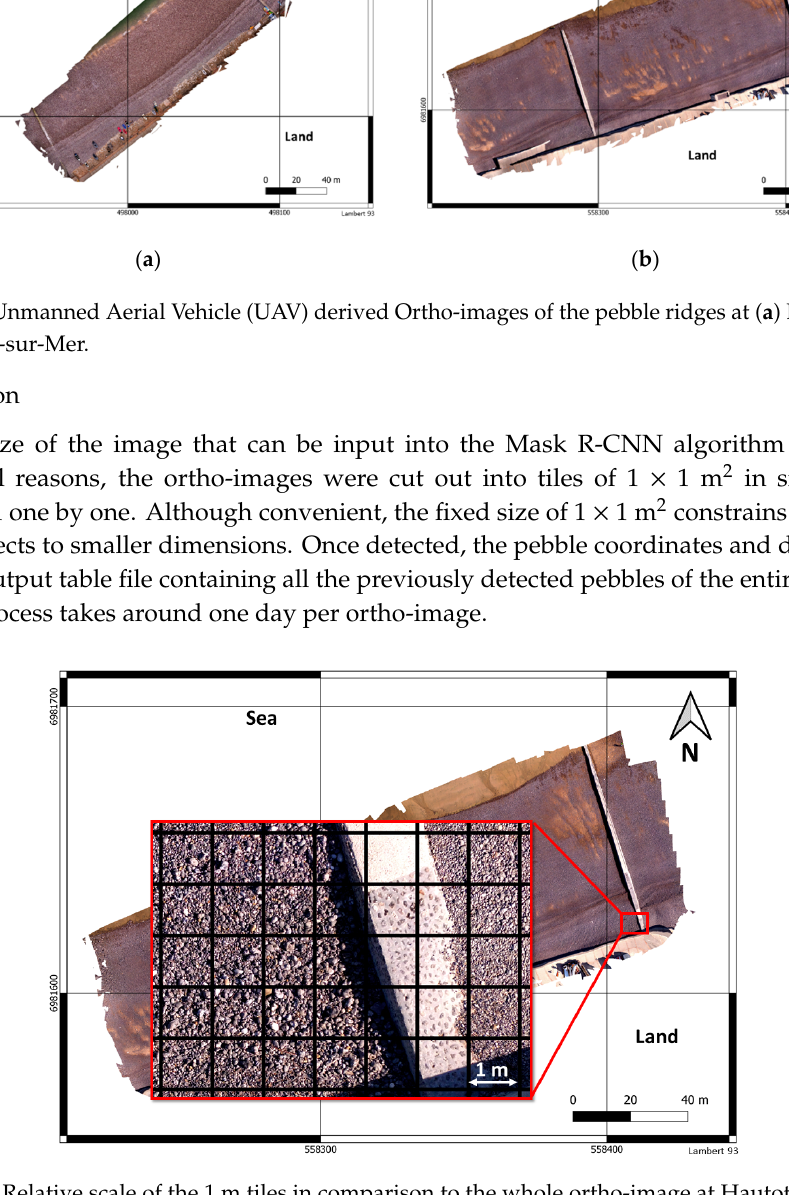
( b ) Figure 9. Comparison between the image quality of ( a ) an ortho-image (resolution 5 mm/pixel), and ( b ) a quadra image (resolution 0.5 mm/pixel). The white square shows the quadra position.